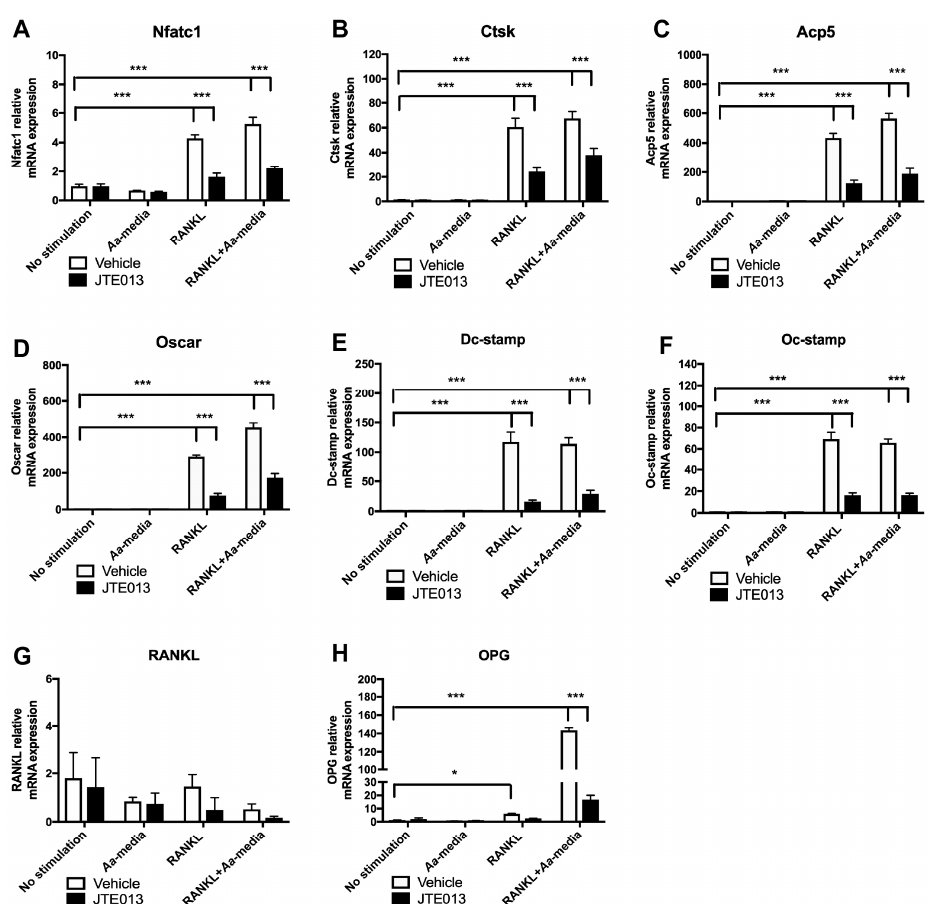
Figure 5. Inhibition of S1PR2 by its specific antagonist (JTE013) attenuated Nfatc1, Ctsk, Acp5, Oscar, Dc-stamp, and Oc-stamp mRNA expressions induced by RANKL with or without co-culture with Aa -stimulated cell culture media. Murine BMs were treated with vehicle or JTE013. Cell were either unstimulated, cultured with Aa -stimulated cell culture media ( Aa -media) alone, RANKL alone, or co-cultured with both RANKL and Aa -media as described in Methods. ( A ) Nfatc1 mRNA, ( B ) Ctsk mRNA, ( C ) Acp5 mRNA, ( D ) Oscar mRNA, ( E ) Dc-stamp mRNA, ( F ) Oc-stamp mRNA, ( G ) RANKL mRNA, and ( H ) OPG mRNA levels were quantified by real time PCR and normalized by GAPDH expression. (* p < 0.05, *** p < 0.001).